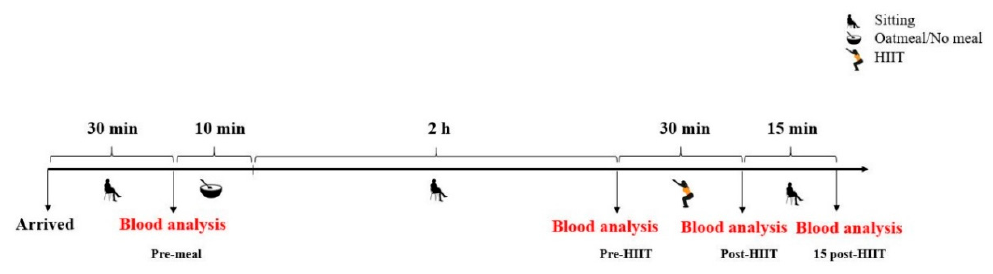
Figure 1. Study design overview. HIIT: high-intensity interval training.